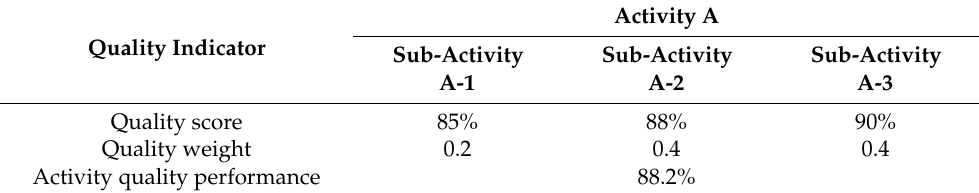
Table 2. Quantification of quality performance of construction project